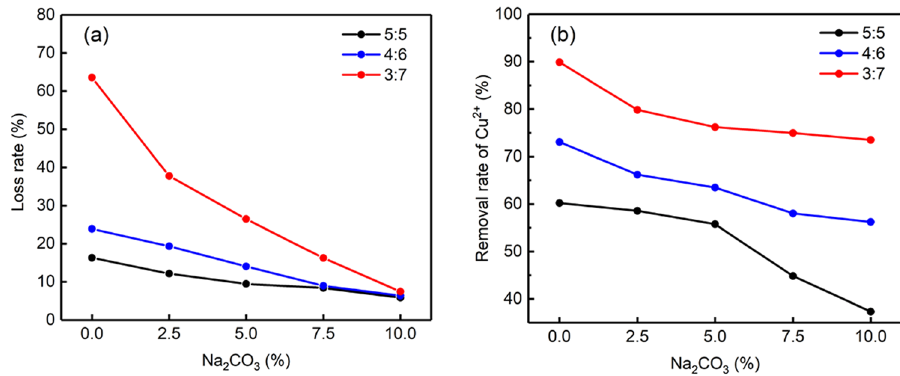
Figure 4. Effect of different Na 2 CO 3 doses on ( a ) the particle loss rate and ( b ) the Cu 2+ removal rate.